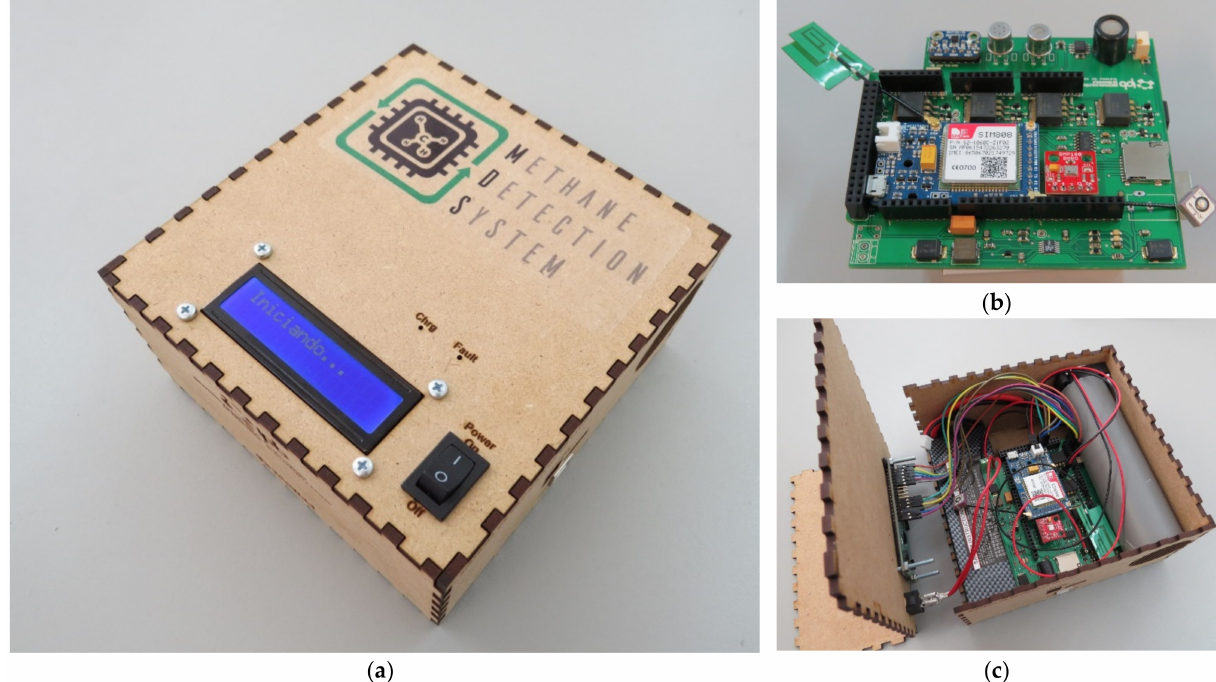
Figure 7. ( a ) Final system inside the wood casing with an LCD display and power button at the top; ( b ) PCB with all components and sensors fixed and welded, the PCB was mounted on top of the Arduino with stackable pins; and ( c ) Distribution of the various elements inside the casing, on the left side the battery, in the middle the PCB and on the right side the air transport